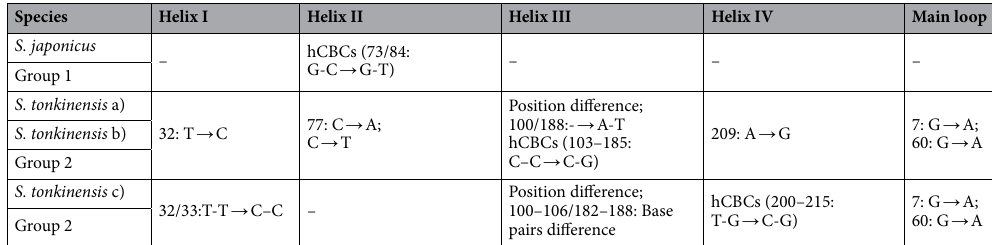
Table 4. Comparison of base differences on the helices of S. tonkinensis and S. japonicus with the samples. Group 1 was the 14 samples identified as S. japonicus , and group 2 was the 16 samples identified as S . tonkinensis by BLAST. –: represents no differences in base